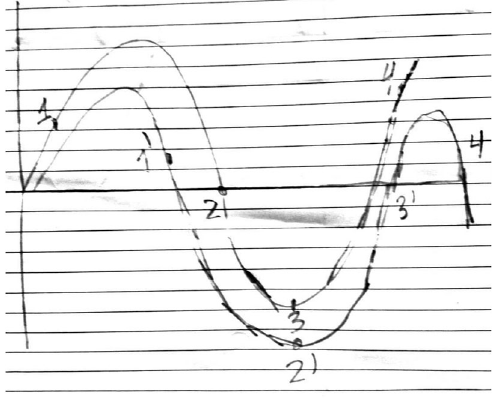
FIG. 6. Hendri ’ s drawing in scaffolding level 1.